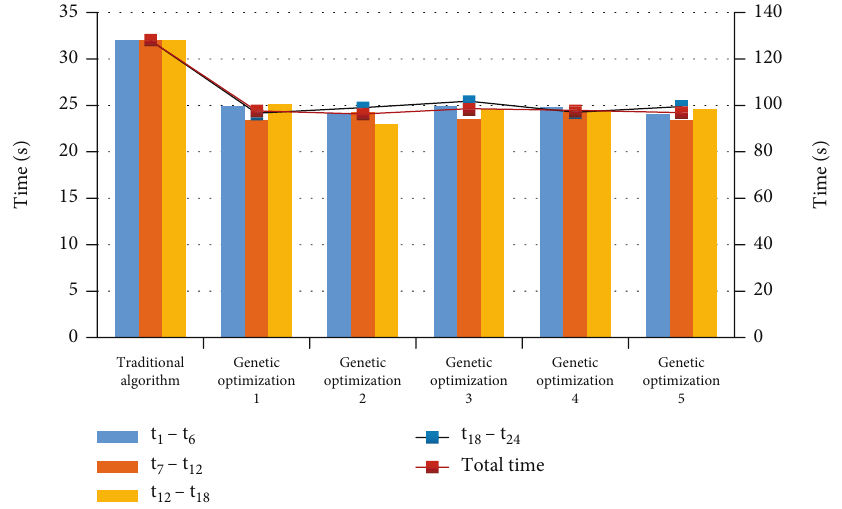
Figure 7: Comparison of path trajectory time between traditional path planning and optimized genetic